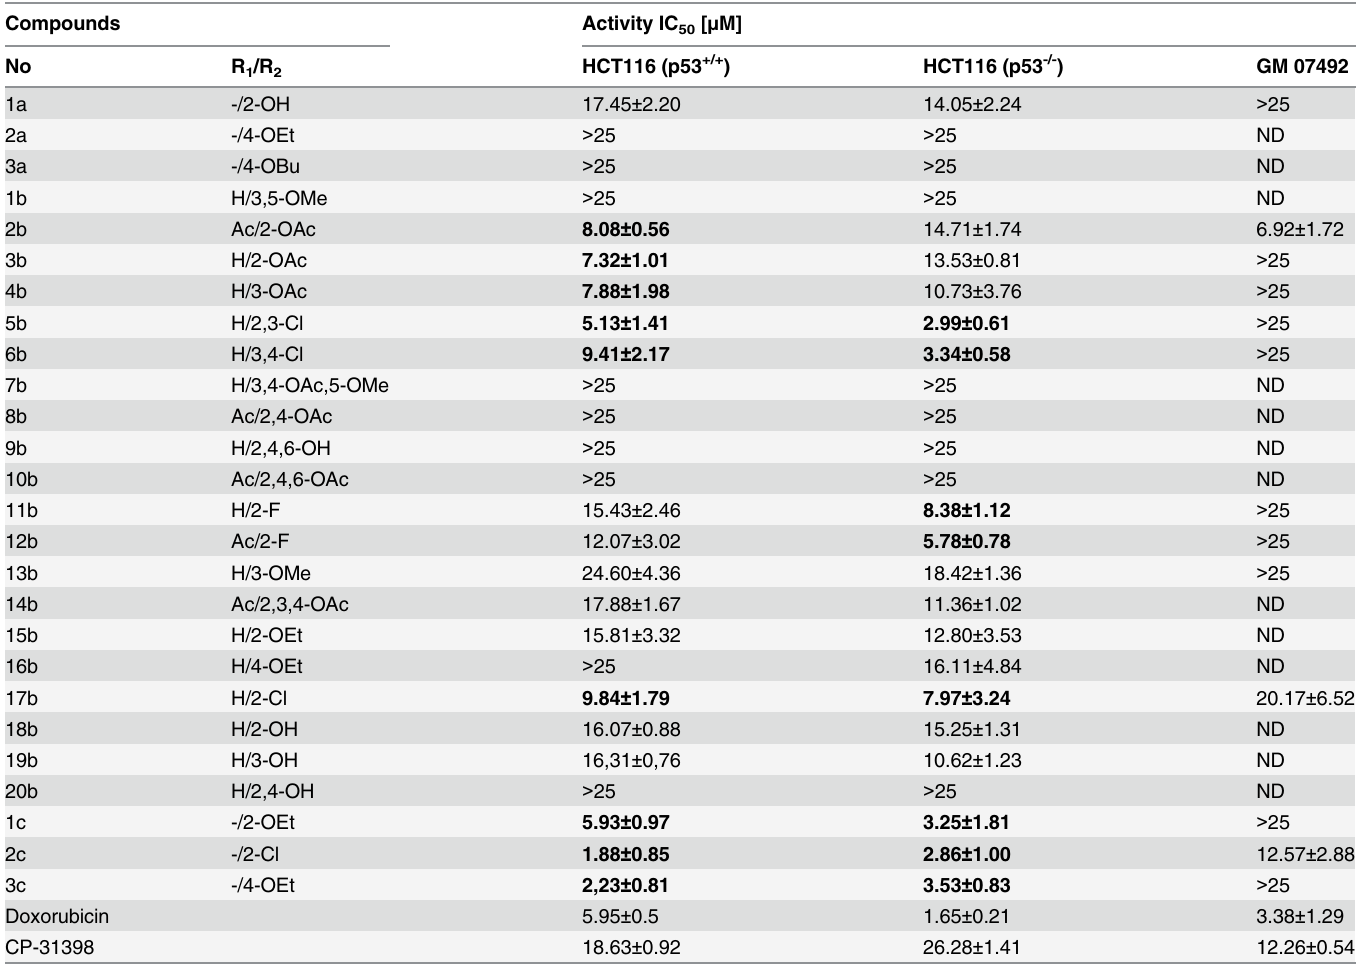
Table 1. Anti-cancer activity of the studied compounds (ND — not determined).